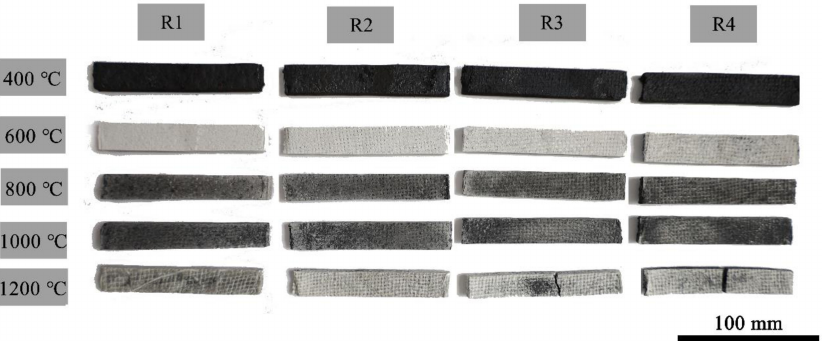
Figure 3. Macroscopic morphology of EP/QF ceramifiable composites after static ablation and blending strength tests.